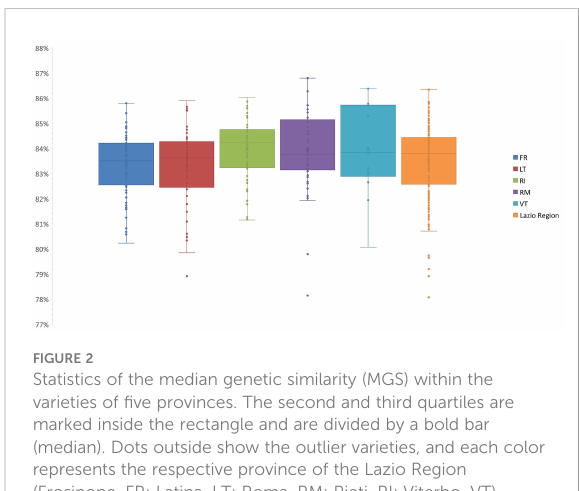
FIGURE 2 Statistics of the median genetic similarity (MGS) within the varieties of fi ve provinces. The second and third quartiles are marked inside the rectangle and are divided by a bold bar (median). Dots outside show the outlier varieties, and each color represents the respective province of the Lazio Region (Frosinone, FR; Latina, LT; Roma, RM; Rieti, RI; Viterbo,